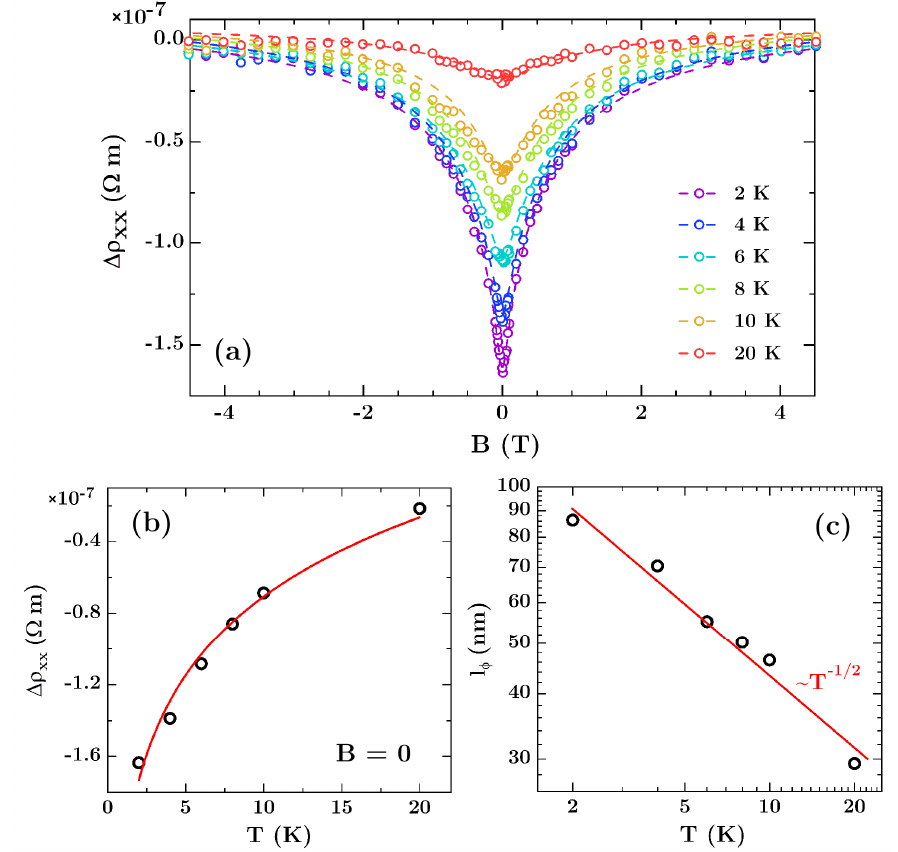
Figure 3. ( a ) Longitudinal magnetoresistivity for the non-patterned Bi film of 50 nm after subtracting the B-quadratic background. Dashed lines represent theoretical curves fitted to experimental data using Equation (4) and HLN theory. ( b ) Resistivity deviation from the classical magnetoresistance at low T and B = 0 T due to weak antilocalization. The red line represents Equation (3) with dephasing exponent p = 1. ( c ) Temperature dependence of phase coherence length l ϕ plotted on a logarithmic scale. The red solid line shows the prediction of the 2-dimensional carrier model, which gives rise to the power-law dependence with exponent of −1/2. Table 1. Summary of the parameters extracted from fits to WAL peaks with Equation (4) for flat reference Bi film and antidot arrays. Antidot Arrays Flat Film